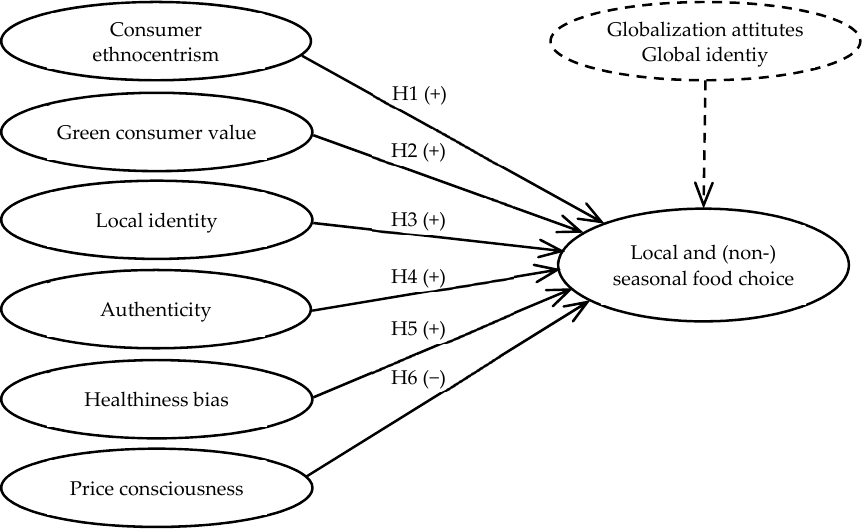
Figure 1. Conceptual research model.